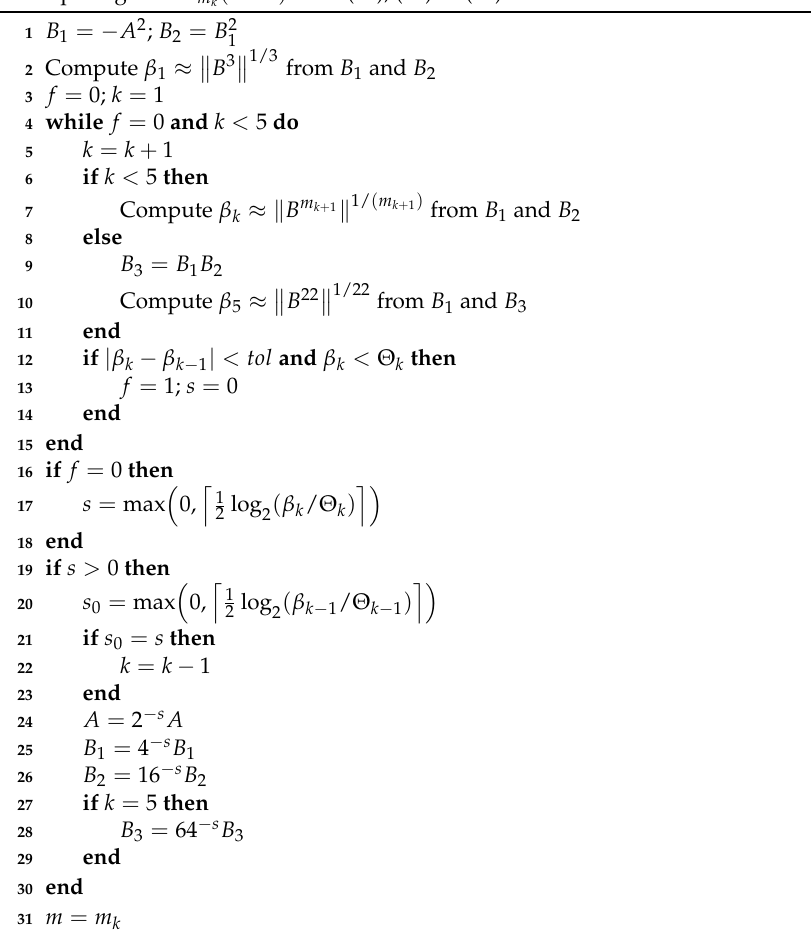
Algorithm 5: Given a matrix A ∈ C n × n , the values Θ from Table 2, M = { 2,4,8,14,21 } and a tolerance tol , this algorithm computes the order of Taylor approximation m k ∈ M and the scaling factor s , together with 2 − s A and the necessary powers of 4 − s B for ( 4 − s B ) from (10), (11) or computing 2 − s AP m k